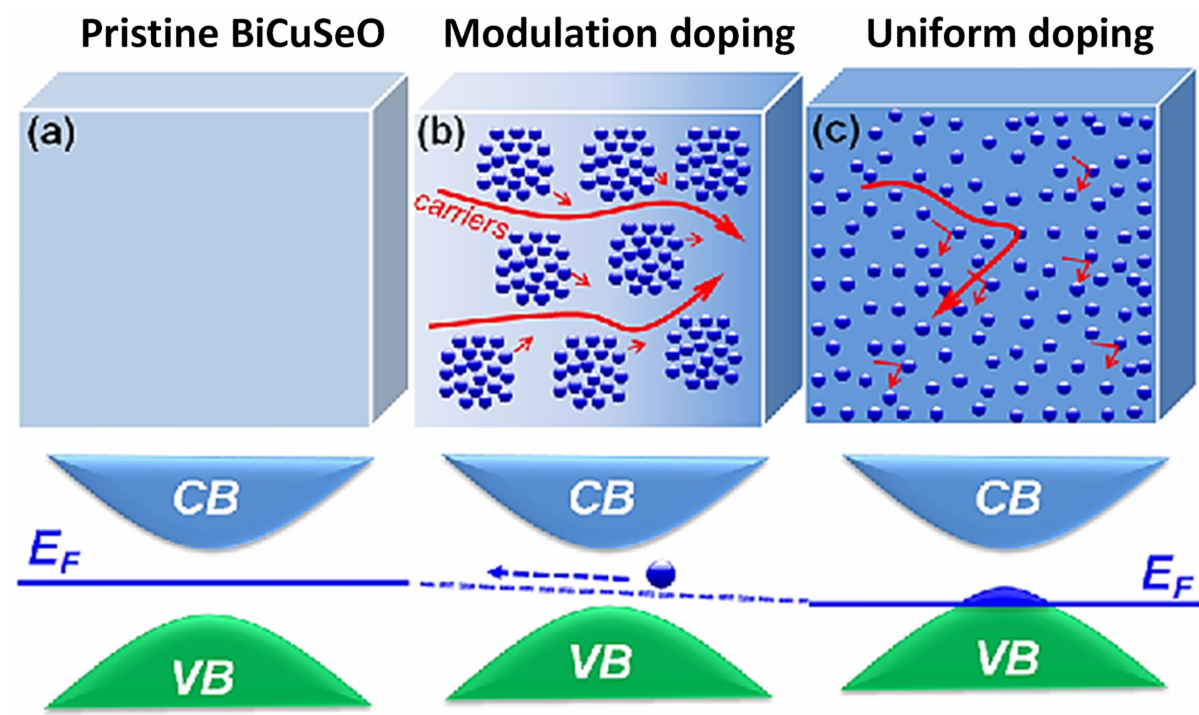
Figure 7. Schematic showing a carrier transport in ( a ) pristine BiCuSeO, ( b ) modulation-doped and ( c ) uniformly doped samples. Figure reproduced with permission from “High Thermoelectric Performance Realized in a BiCuSeO System by Improving Carrier Mobility through 3D Modulation Doping” from Pei et al., 2014